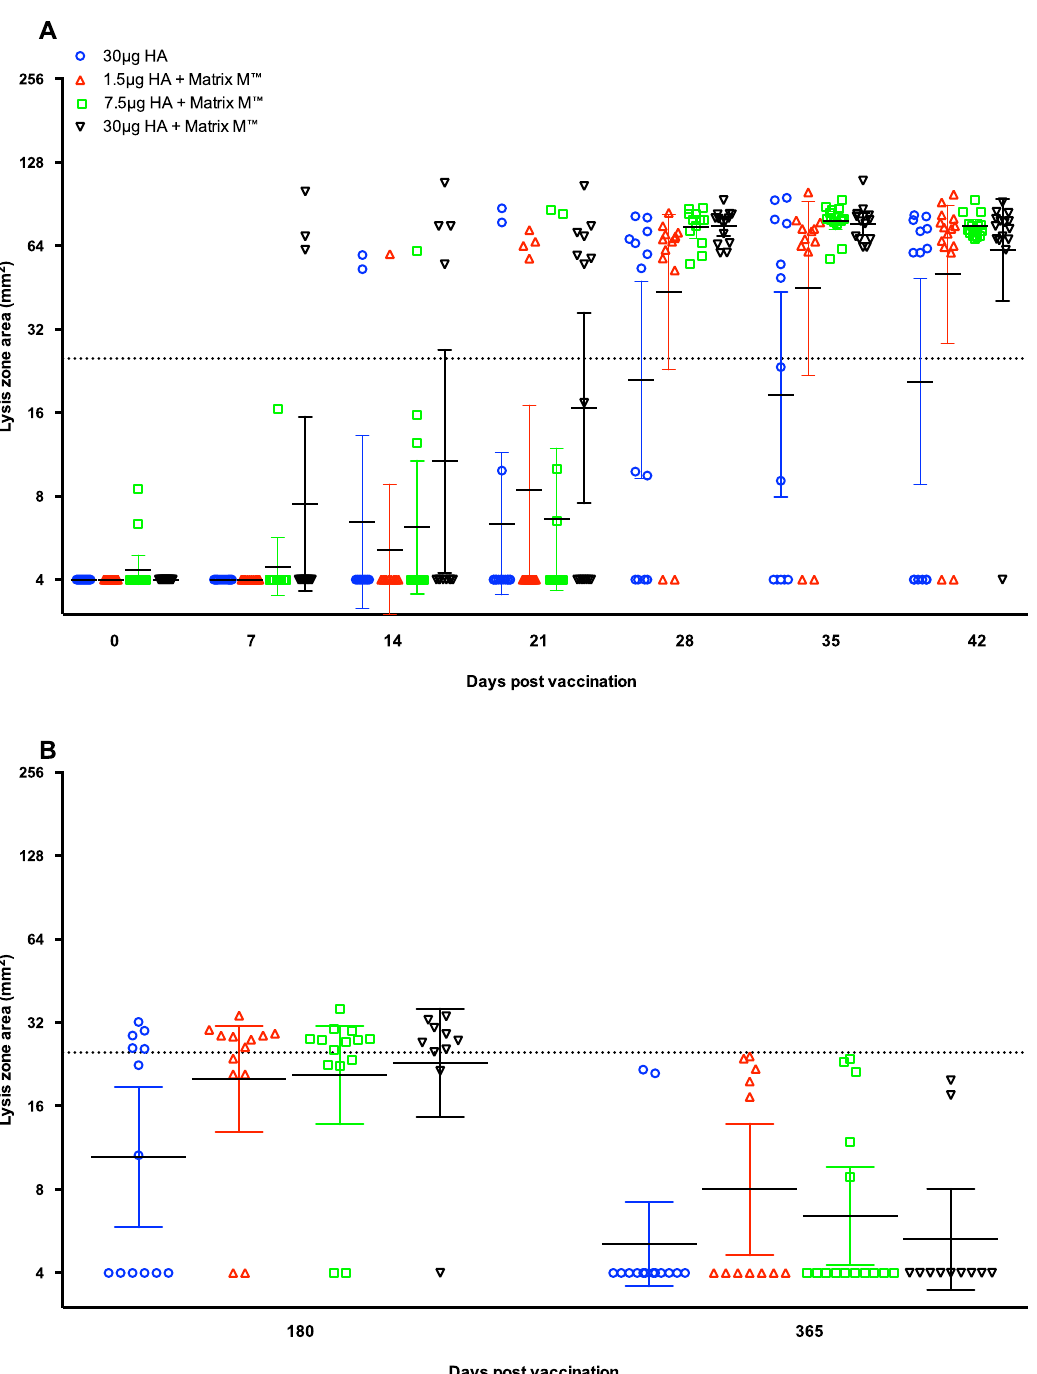
Fig 3. The kinetics and long-term single radial haemolysis antibody response induced after vaccination. The kinetics (A) and long-term (B) single radial haemolysis response to the homologous vaccine strain A/Vietnam/1194/2004 (NIBRG-14) after vaccination with two doses (21 ± 1 days apart) of inactivated virosomal H5N1 vaccine alone (30 μ g HA, blue) or 1.5 (red), 7.5 (green) or 30 μ g HA (black) adjuvanted with Matrix-M (50 μ g). The sampling day after vaccination is shown on the x-axis. Each symbol represents the geometric mean lysis zone area (mm 2 ) for one individual participant, with the group geometric mean and 95% confidence interval presented. The dotted line shows the seroprotective SRH Zone area of (cid:1) 25mm 2 .